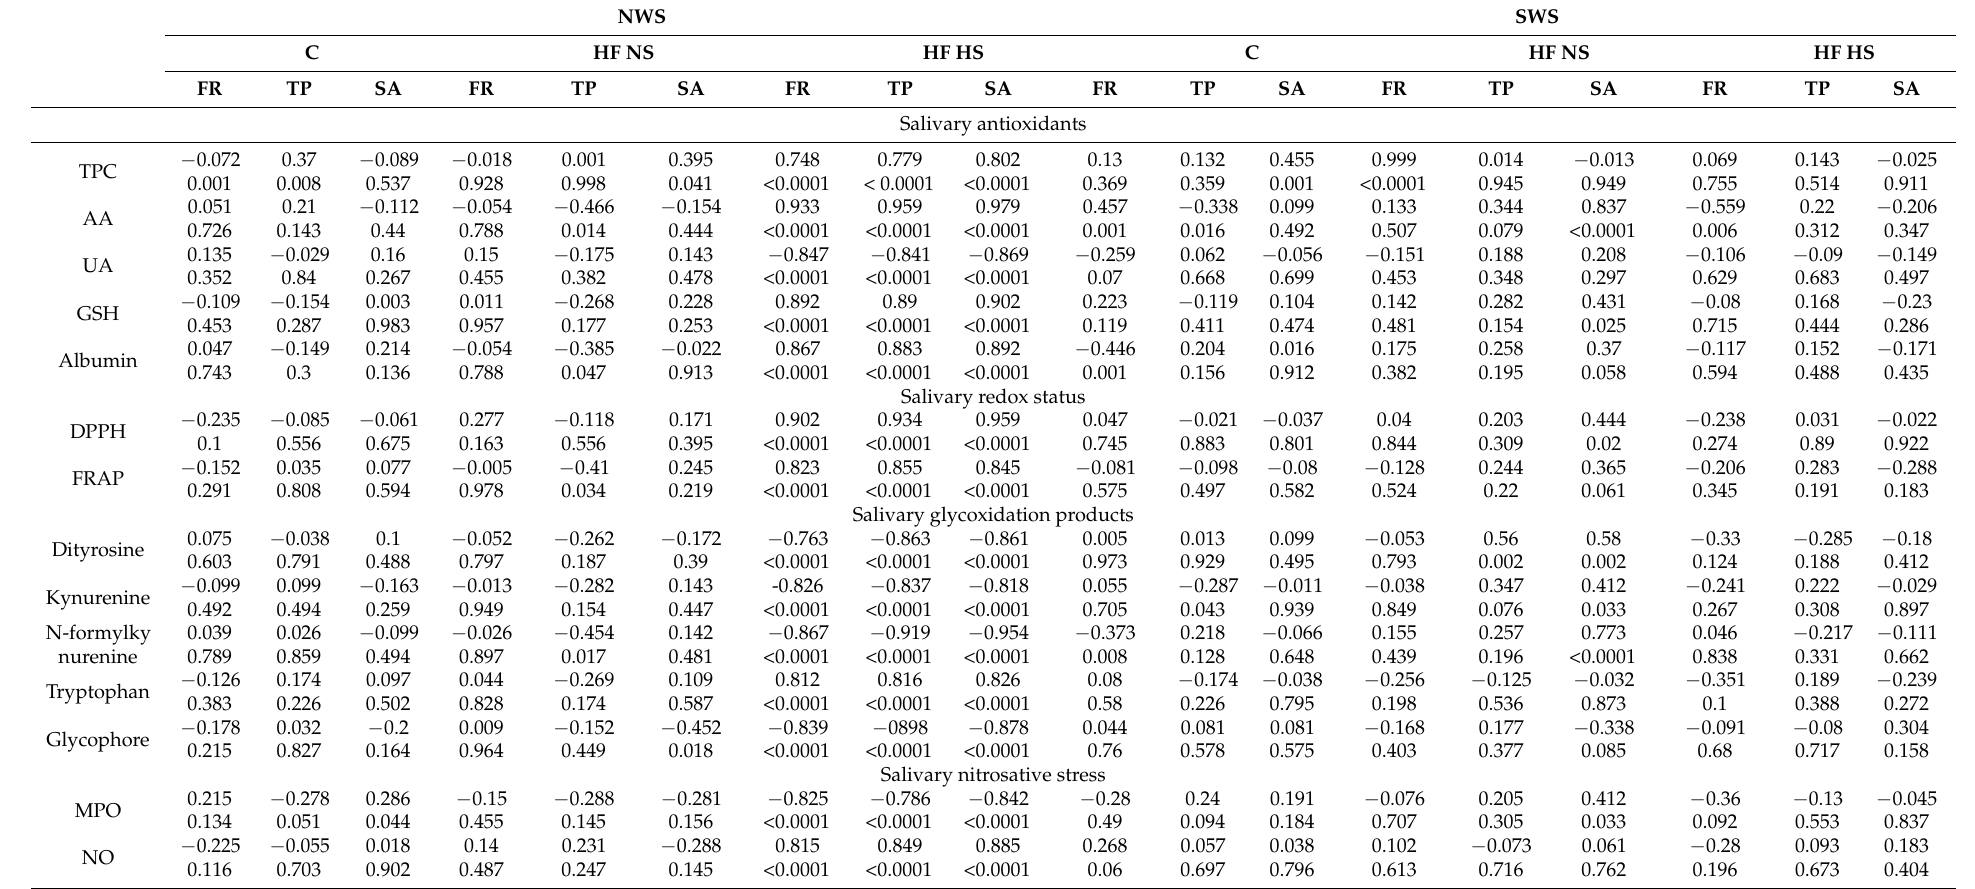
Table 5. Correlations between salivary redox biomarkers and secretory function of salivary